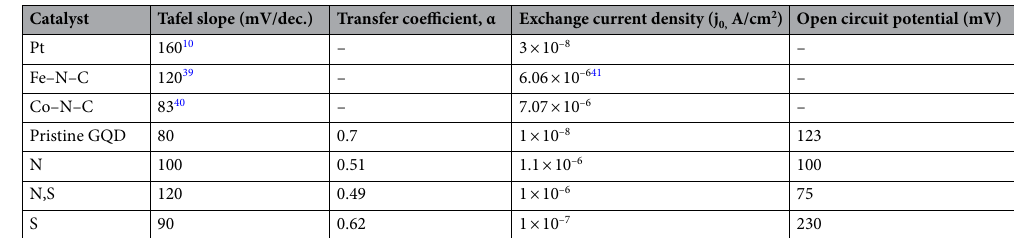
Table 1. Comparison of the kinetic parameters from Tafel measurements of the GQDs; similar values for bench-marks electrocatalysts are also indicated in O 2 saturated 0.1 M KOH. Exchange current densities were calculated from the intercepts and apparent Tafel slopes.